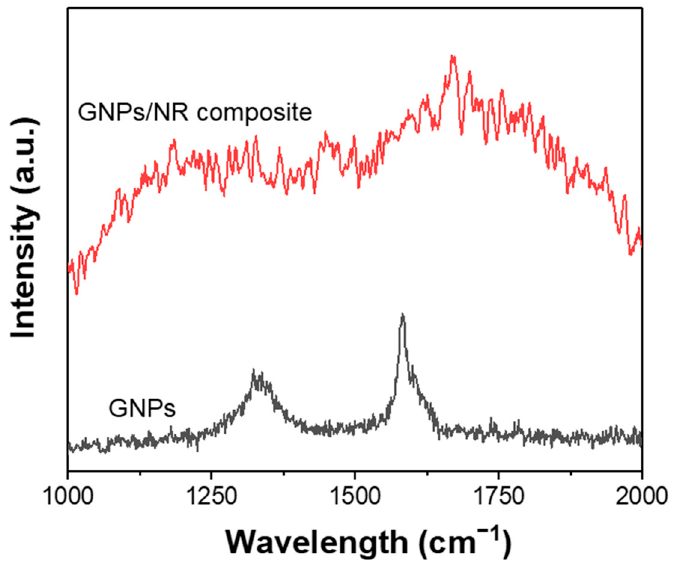
Figure 5. The Raman spectra of the modified GNPs ( black line ) and the modified GNPs/NR composite ( red line